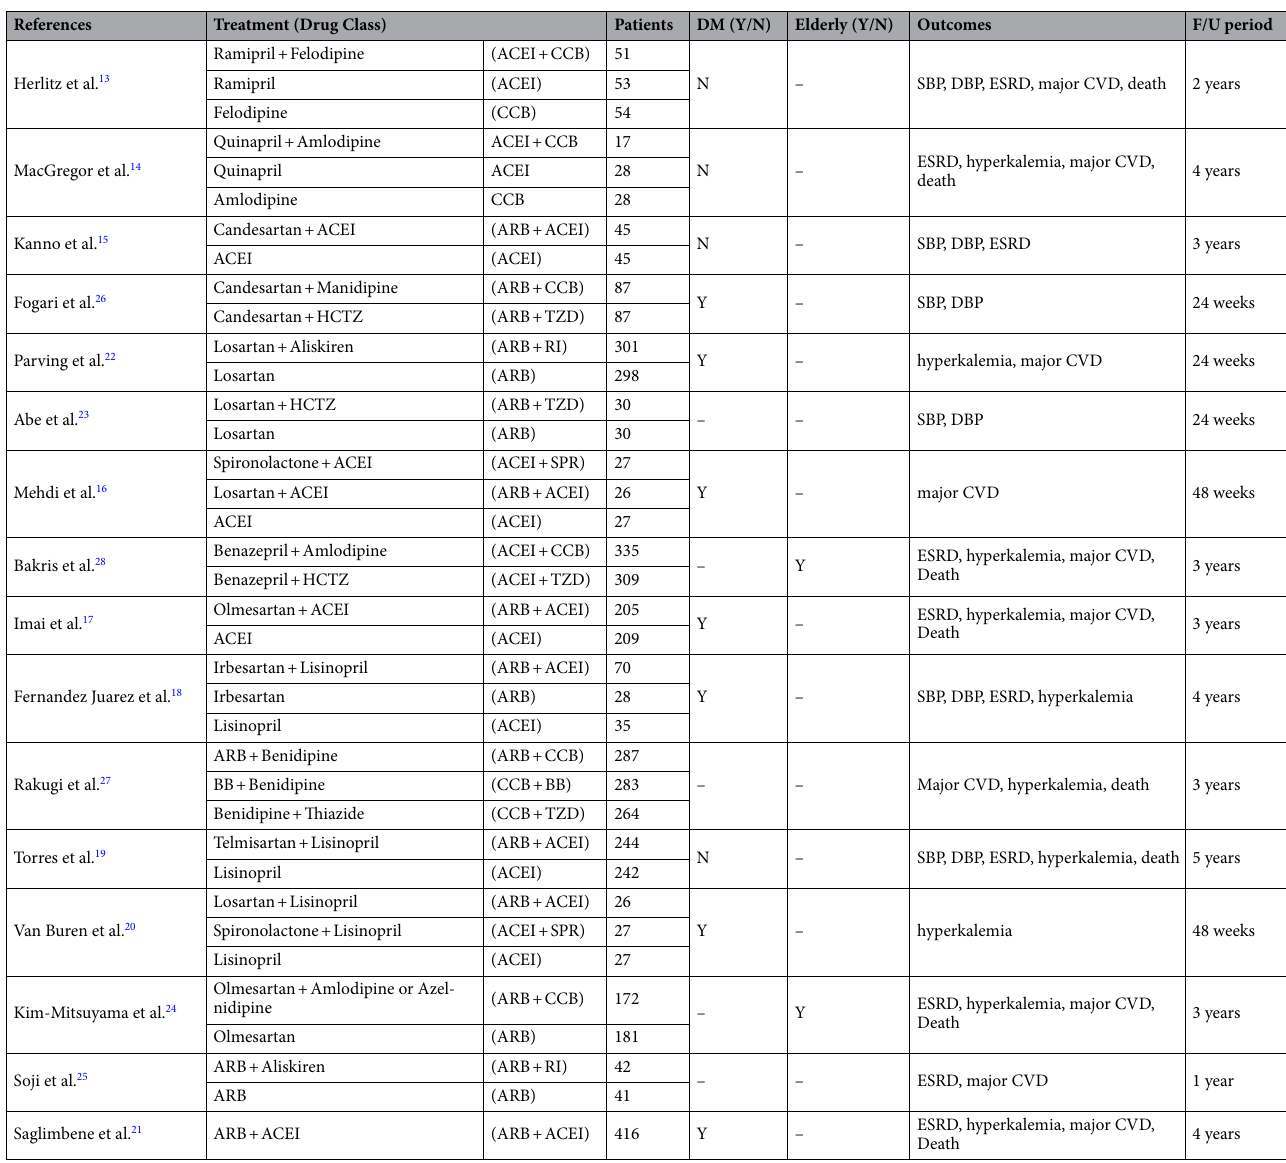
Table 1. Study characteristics. ACEI, angiotensin converting enzyme inhibitor; ARB, angiotensin receptor blocker; BB, beta-blocker; CCB, calcium channel blocker; CVD, cardiovascular disease; DBP, diastolic blood pressure; ESRD, end stage renal disease; F/U, follow up; RI, renin inhibitor; SBP, systolic blood pressure; SPR, spironolactone; TZD,